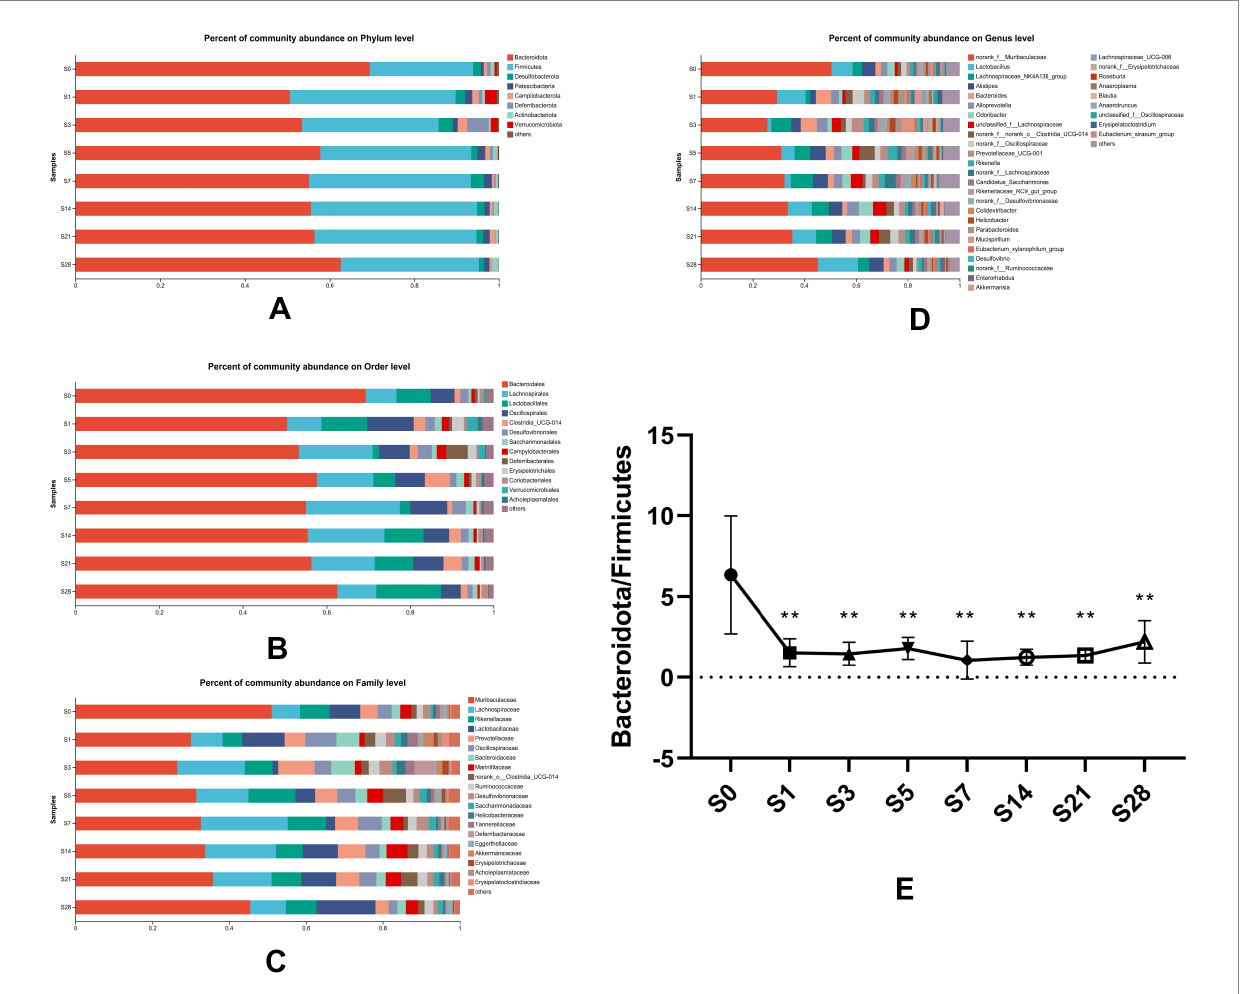
FIGURE 3 Composition of gut microbial communities altered over time. Bacterial community composition at the phylum (A) , order (B) , family (C), and genus (D) levels. Microbial abundance was calculated as a percentage of the total bacterial taxon within each sample. The bar chart shows the average value for each group. (E) The ratio of Bacteroidetes to Firmicutes, which was found to vary over time, showed significant differences ( ** p < 0.01) when each post-burn group was compared to the pre-burn group. S0, pre-burn; S1, S3, S5, S7, S14, S21, and S28 represent days 1, 3, 5, 7, 14, 21, and 28 post-burn,